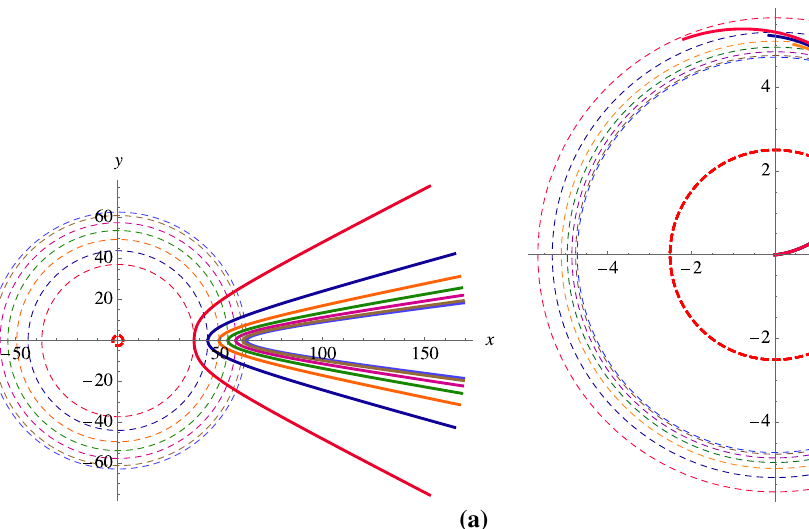
( a ) (b) of E 2 decreases from the inner to the outer circles in the OFK, and from the outer to the inner circles in the OSK